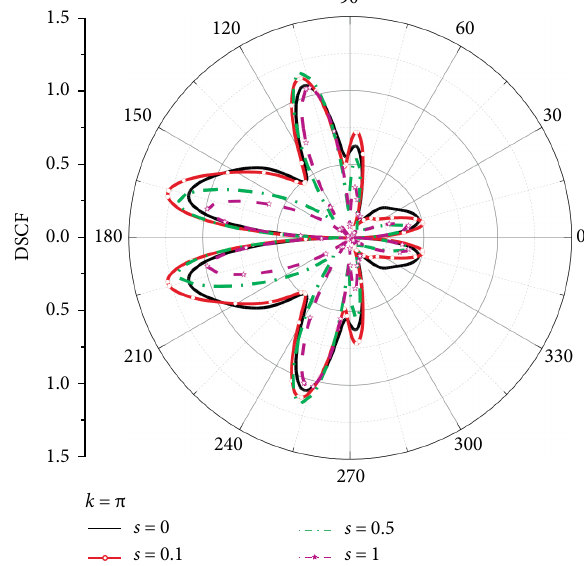
Figure 7: Distributions of DSCF around a square hole with various 𝑠 for 𝐾 = 0.5 .